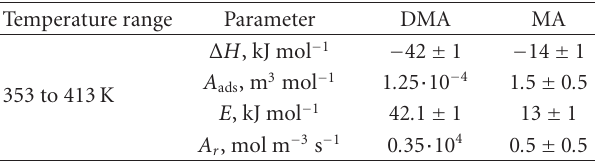
Table 2: Arrhenius equation parameters for the PCO of DMA and